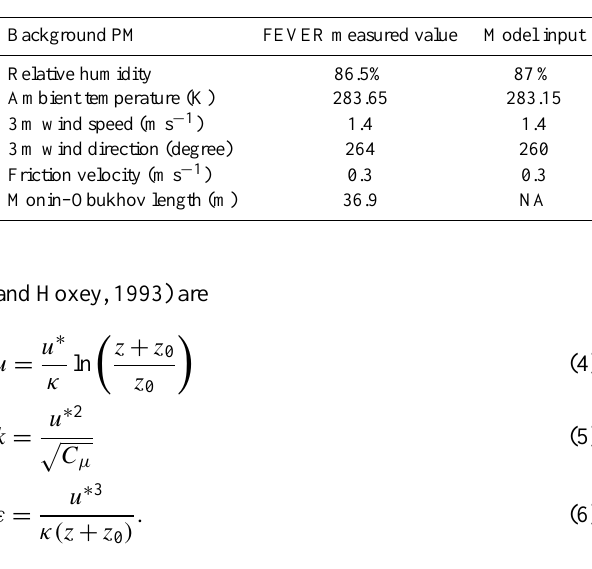
Table 1. Median values of the measured meteorological data and model